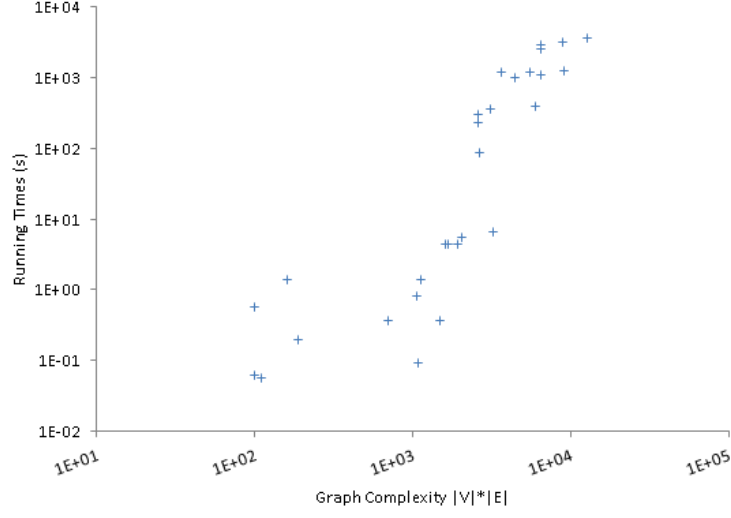
Figure 3. Running times of our fixed-parameter algorithm for varying graph complexities, i.e. , of artificial |𝑽| ⋅ |𝑬|